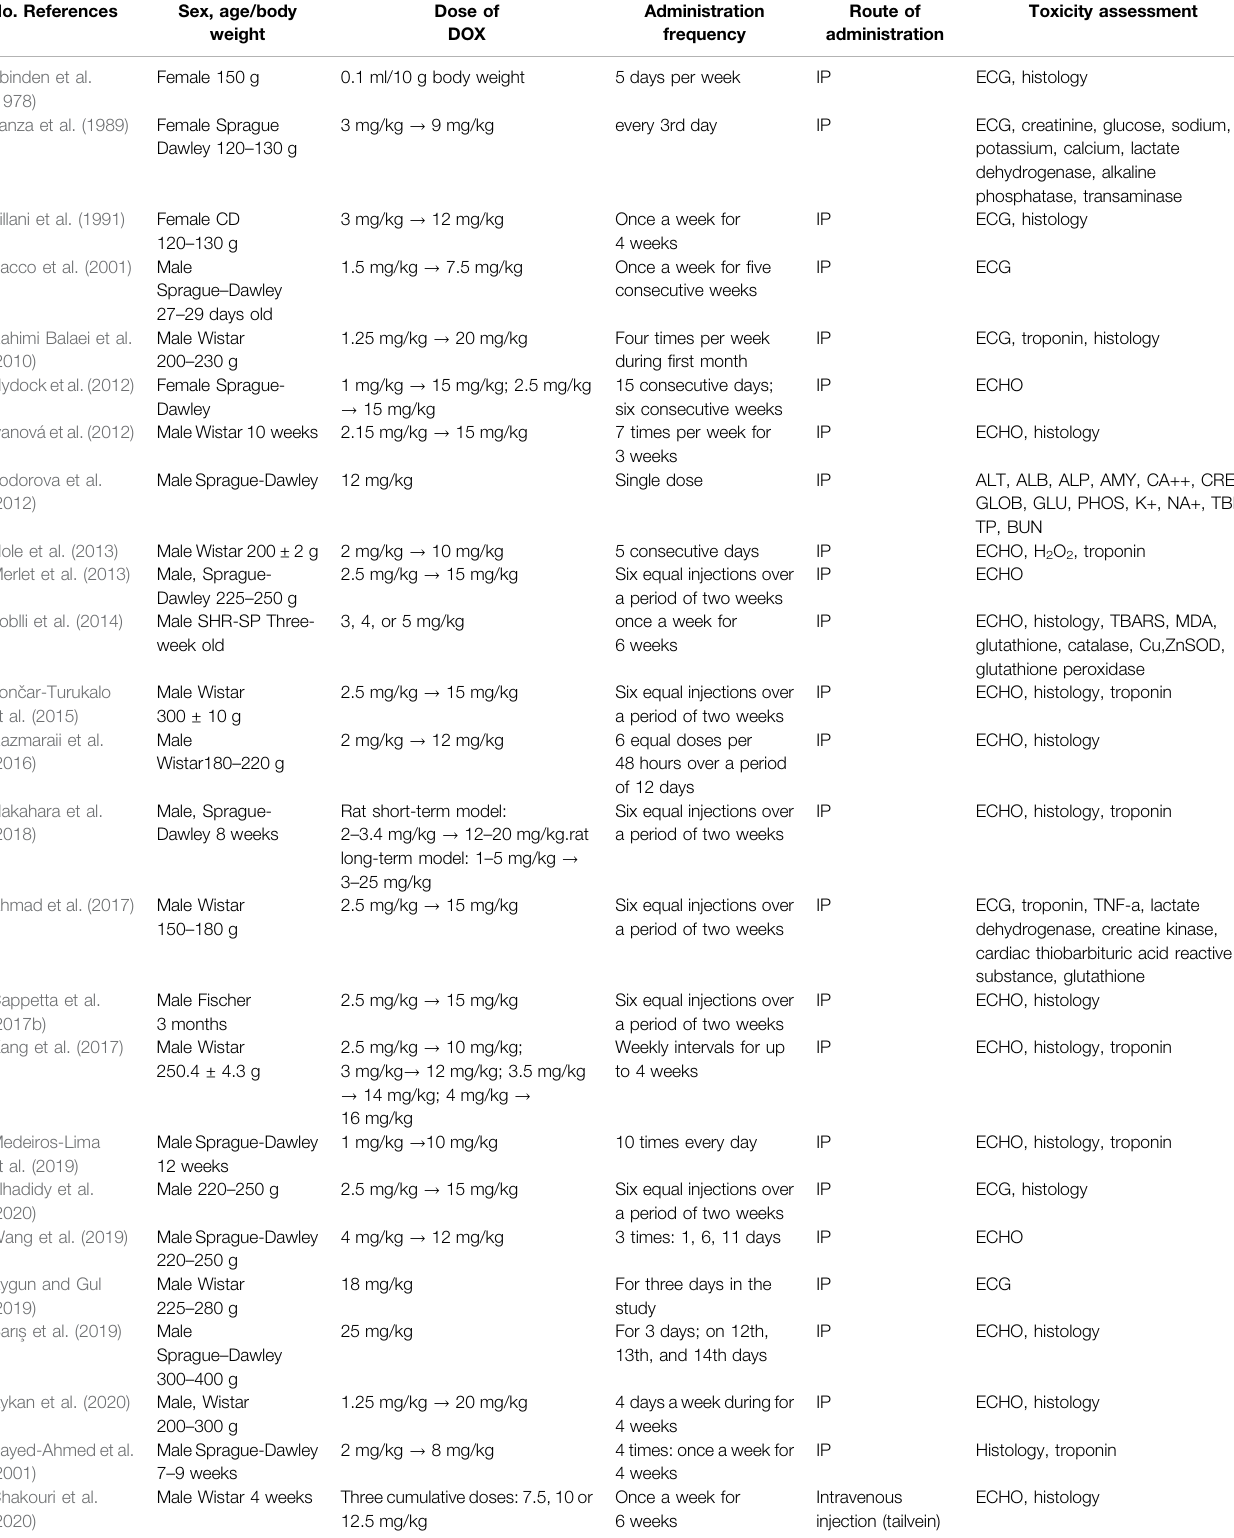
TABLE 1 | Data on the modeling of doxorubicin cardiomyopathy in